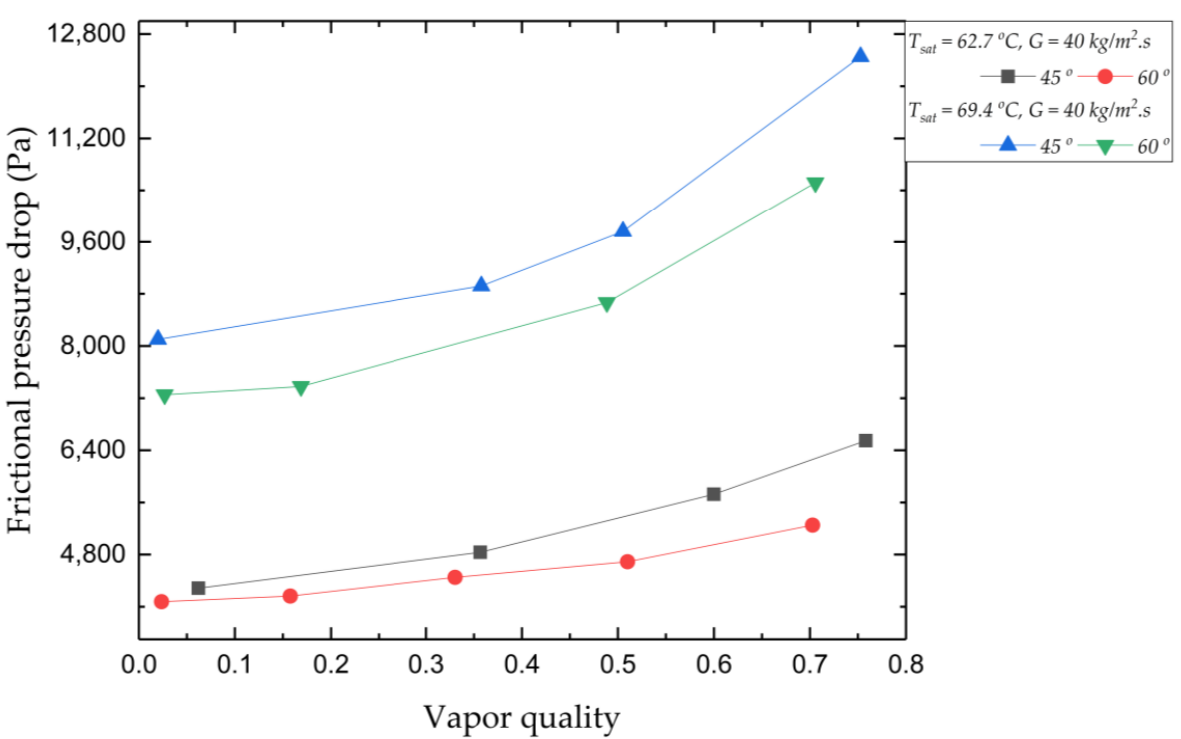
Figure 22. Frictional pressure drop versus quality [103].